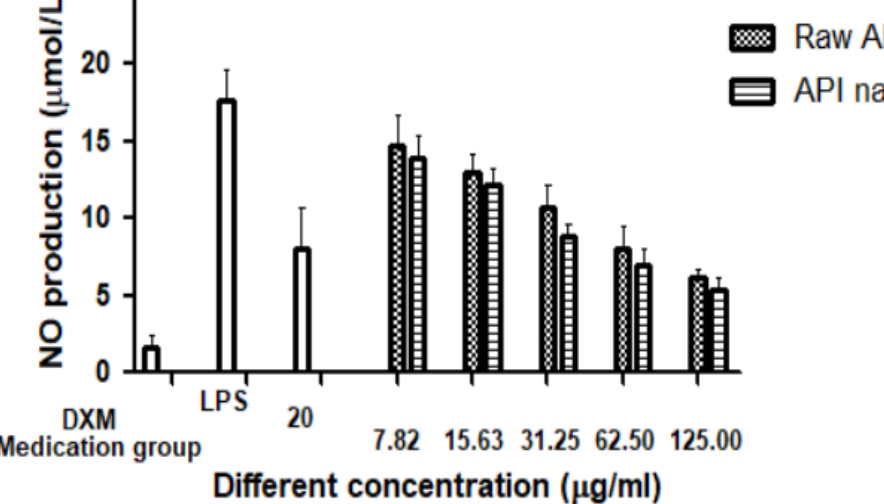
Figure 11. Effects of raw API and API nanoparticles on the NO production of RAW264.7 cells induced by LPS.